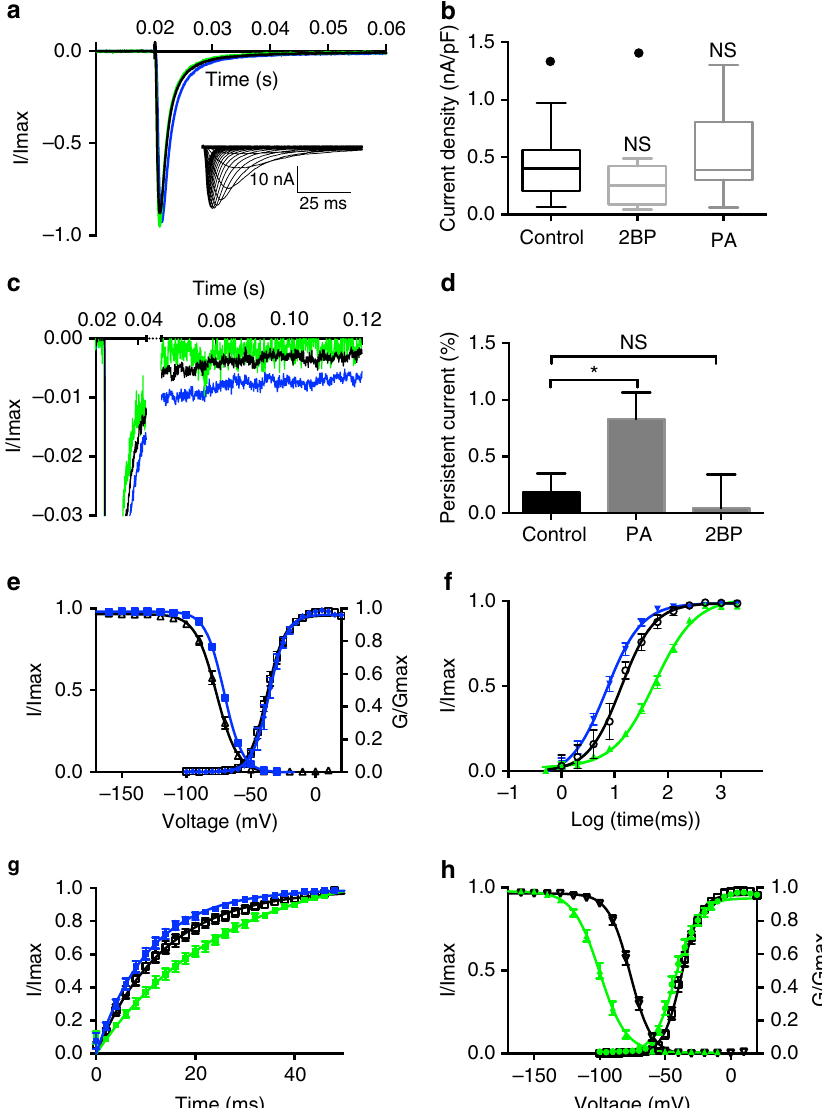
Figure 4 | 2-Br-palmitate(2BP) and palmitic acid(PA) treatments alter biophysical properties of voltage-gated sodium currents in